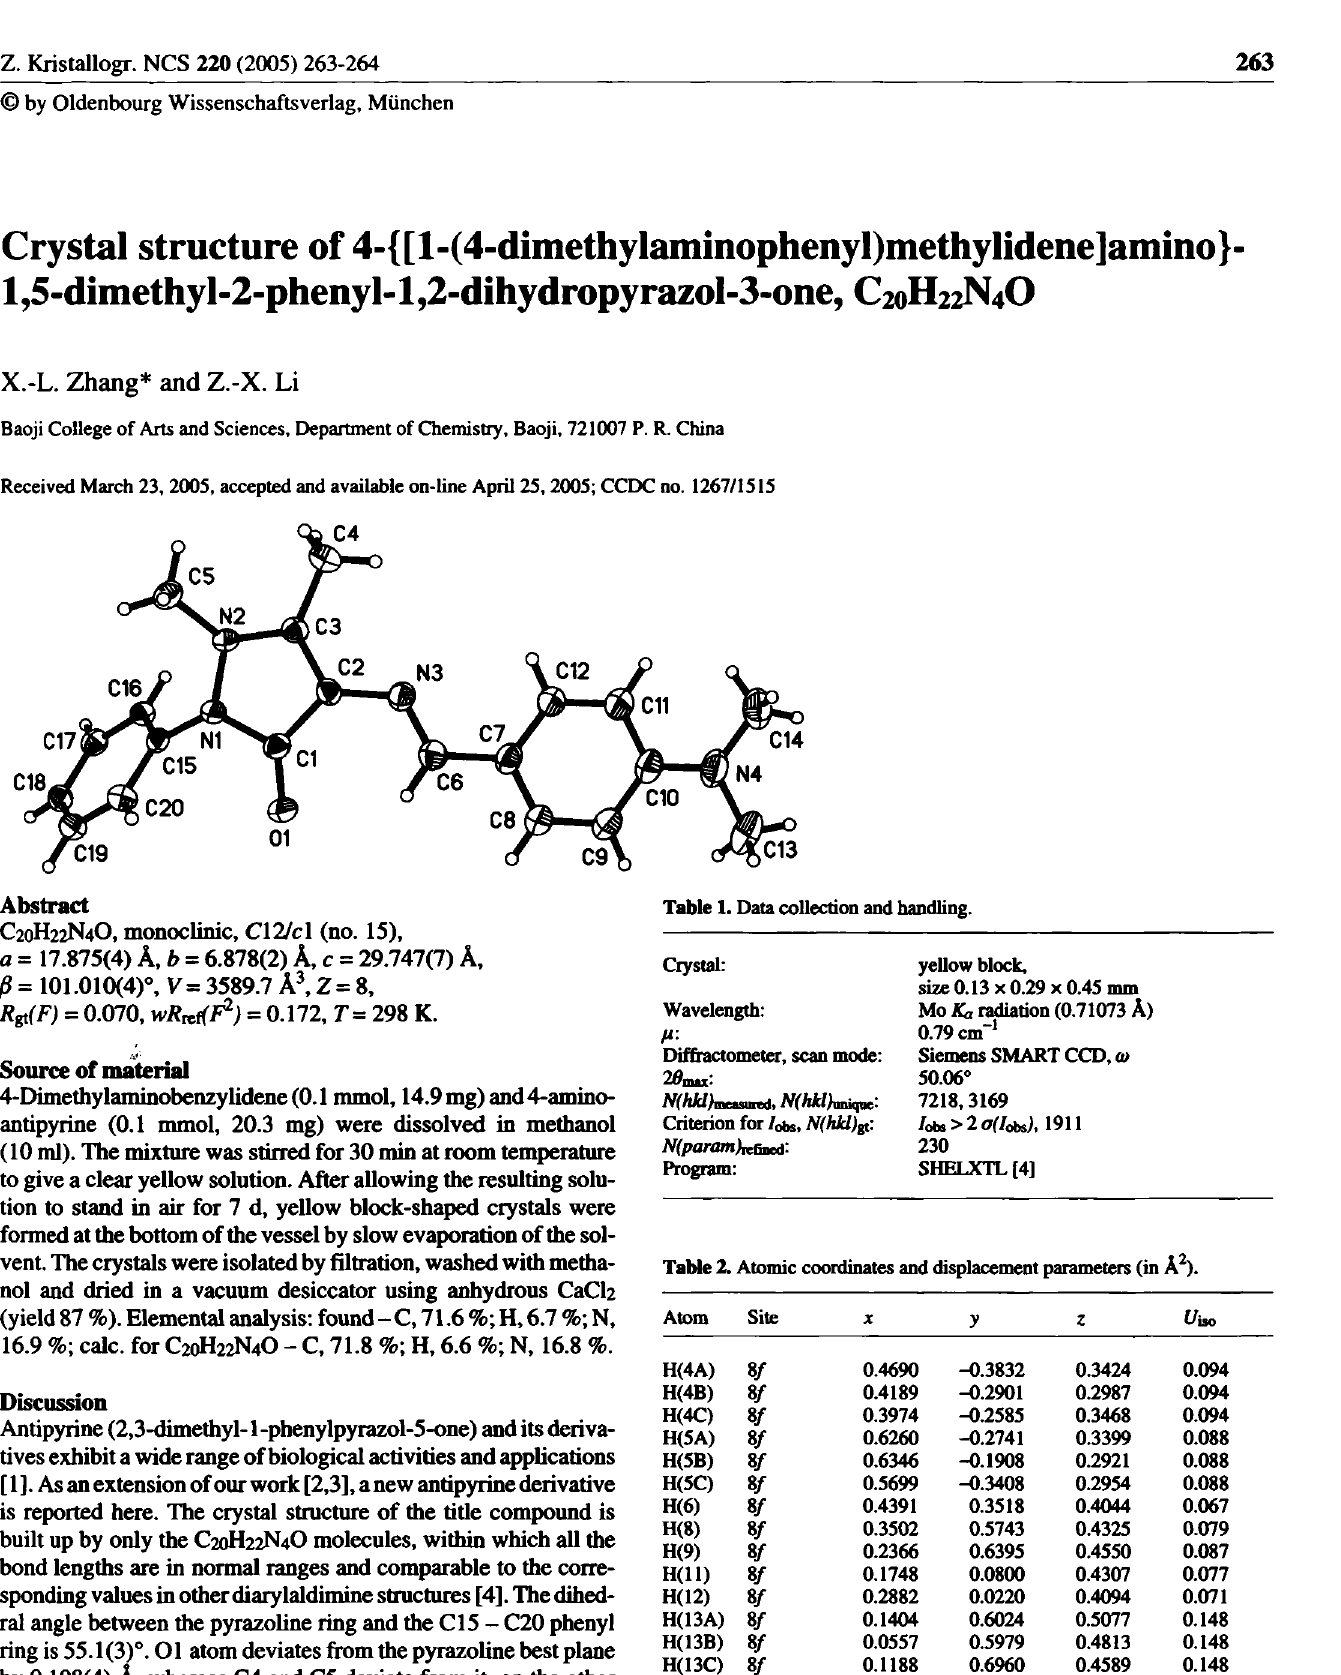
Table 1. Data collection and